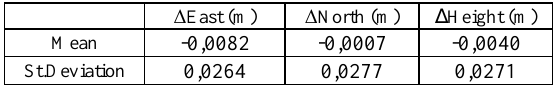
Table 7. Average of the absolute values of the differences between the coordinates of the control points obtained with the total station and those obtained by photogrammetry.